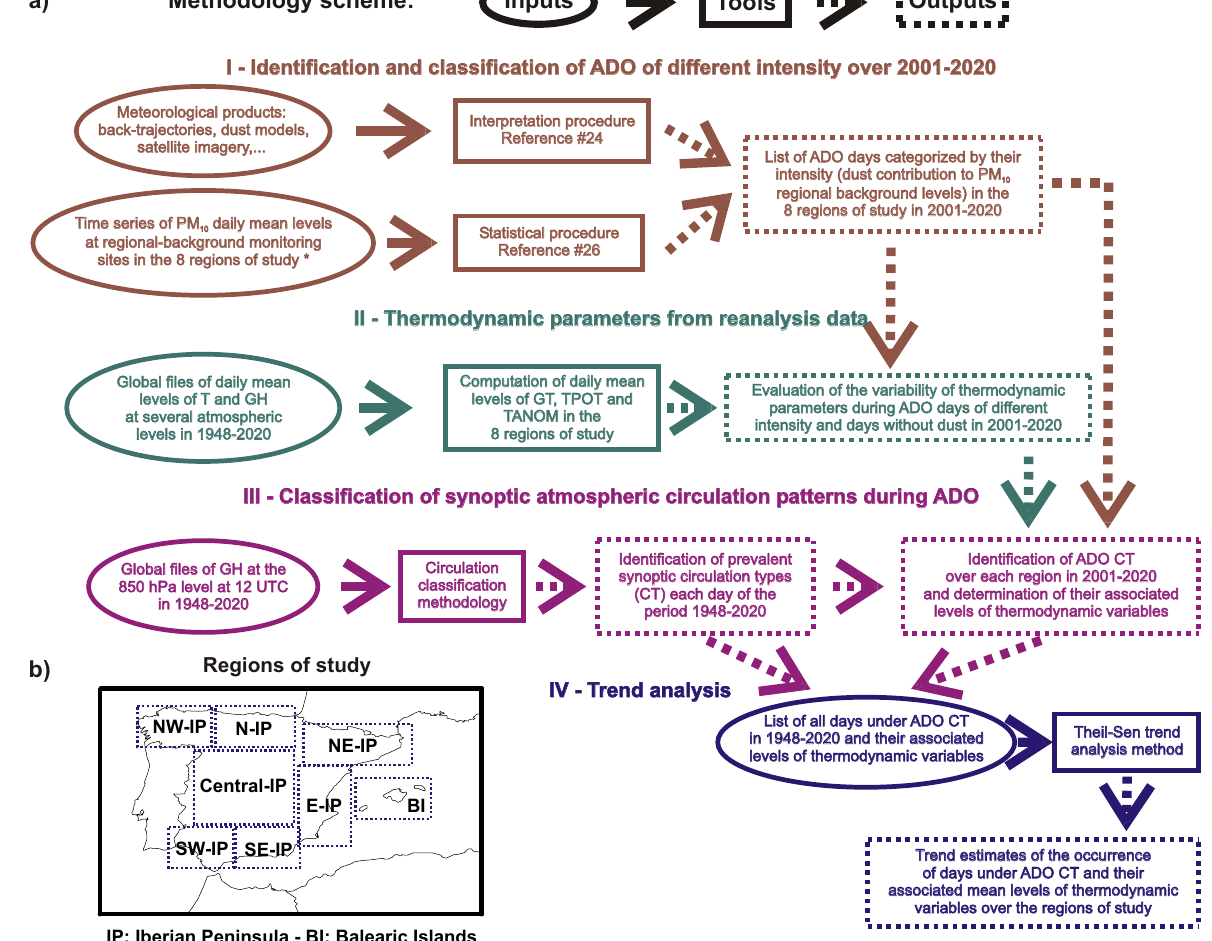
Fig. 1 Methodological scheme. Flow chart showing the stages of the methodology used in this study ( a ) and regions of study ( b ). ADO African dust outbreaks, BI Balearic Islands, IP Iberian